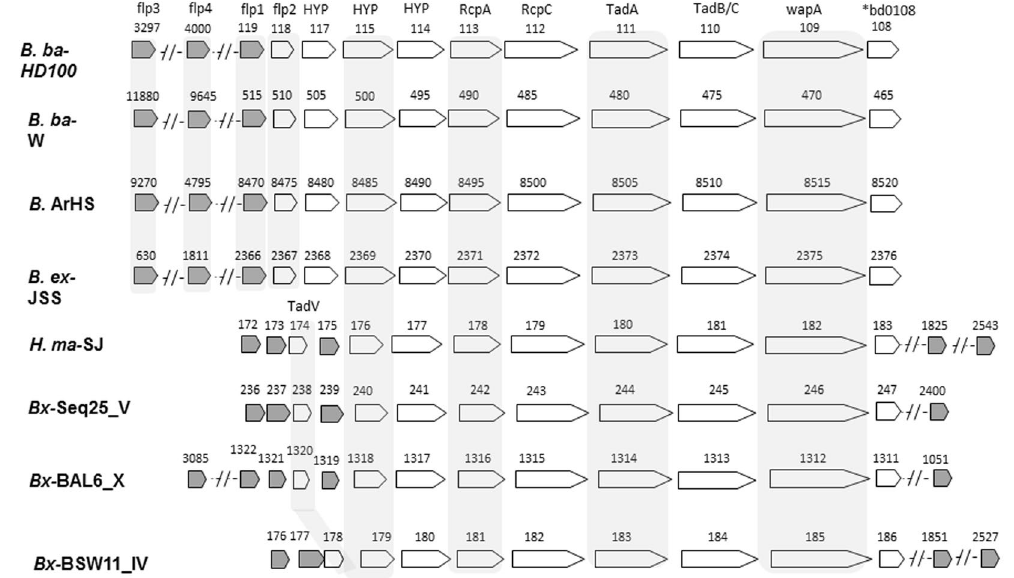
Figure 2. Genomic arrangement of TAD loci in different BALOs. TAD loci from all examined BALOs exhibit synteny. The prepilin peptidase, TadV is missing from all Bdellovibrio genomes but is present in Halobacteriovorax and Bacteriovorax genomes. All BALOs also encode non-TAD associated flp genes. flp 2 is a TAD-associated trimmed flp , that is only present in Bdellovibrio TAD loci and is absent from all other BALOs. BALO species designations- B.ba-HD100: Bdellovibrio bacteriovorus HD100; B.ex-JSS: Bdellovibrio exovorus JSS; B.ba-W: Bdellovibrio bacteriovorus W; B-ArHS: Bdellovibrio sp. ArHS; H.ma-SJ: Halobacteriovorax marinus SJ; Bx-SEQ25_V: Bacteriovorax sp. Seq25_v; Bx- BAL6_X: Bacteriovorax sp. BAL6_X; Bx- BSW11_IV: Bacteriovorax sp.